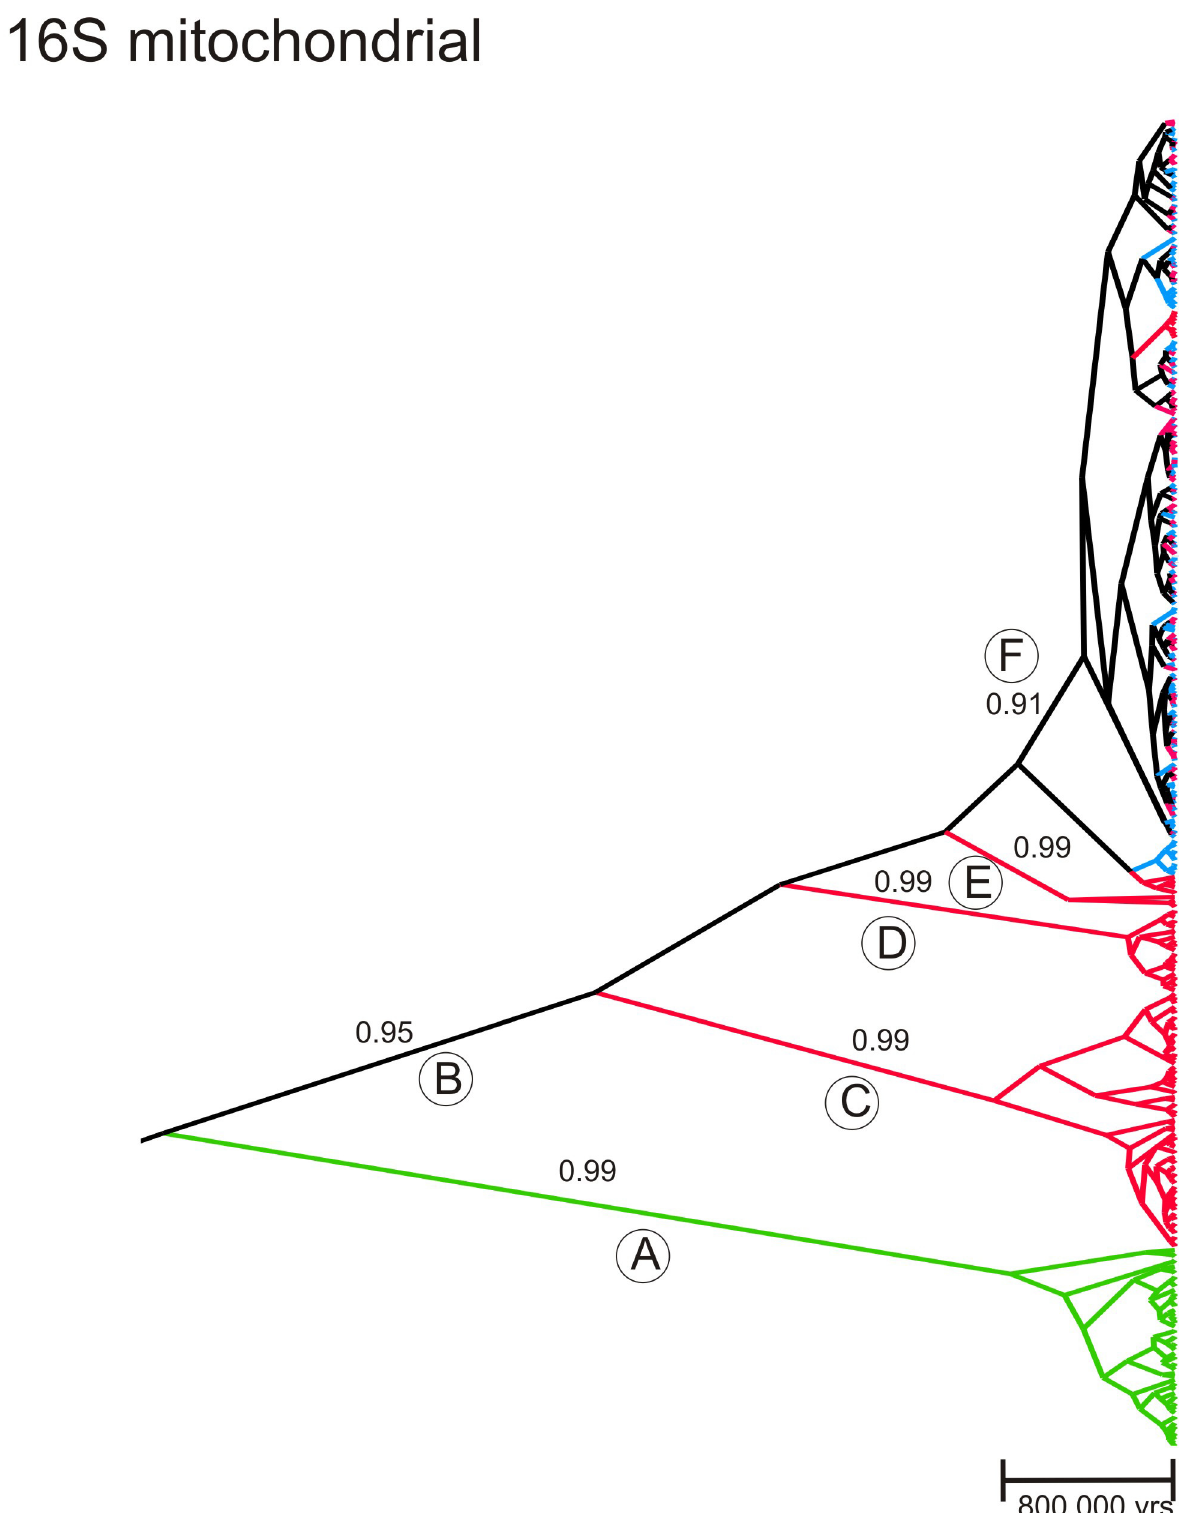
Fig 4. Maximum clade credibility coalescent tree among the mitochondrial 16S sequences using Ixodes ricinus as an outgroup. The time scale is based upon a clock rate for the 16S arthropod gene of 1.06% /million years (My). Numbers above some branches are posterior probabilities (PP) for